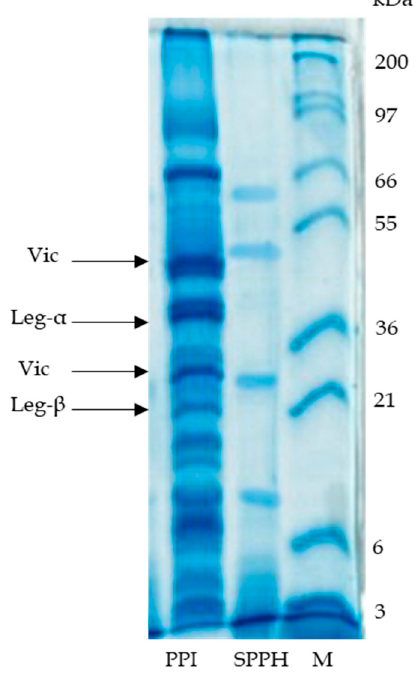
Figure 2. SDS-PAGE of PPI and SPPH. M is referred to marker.